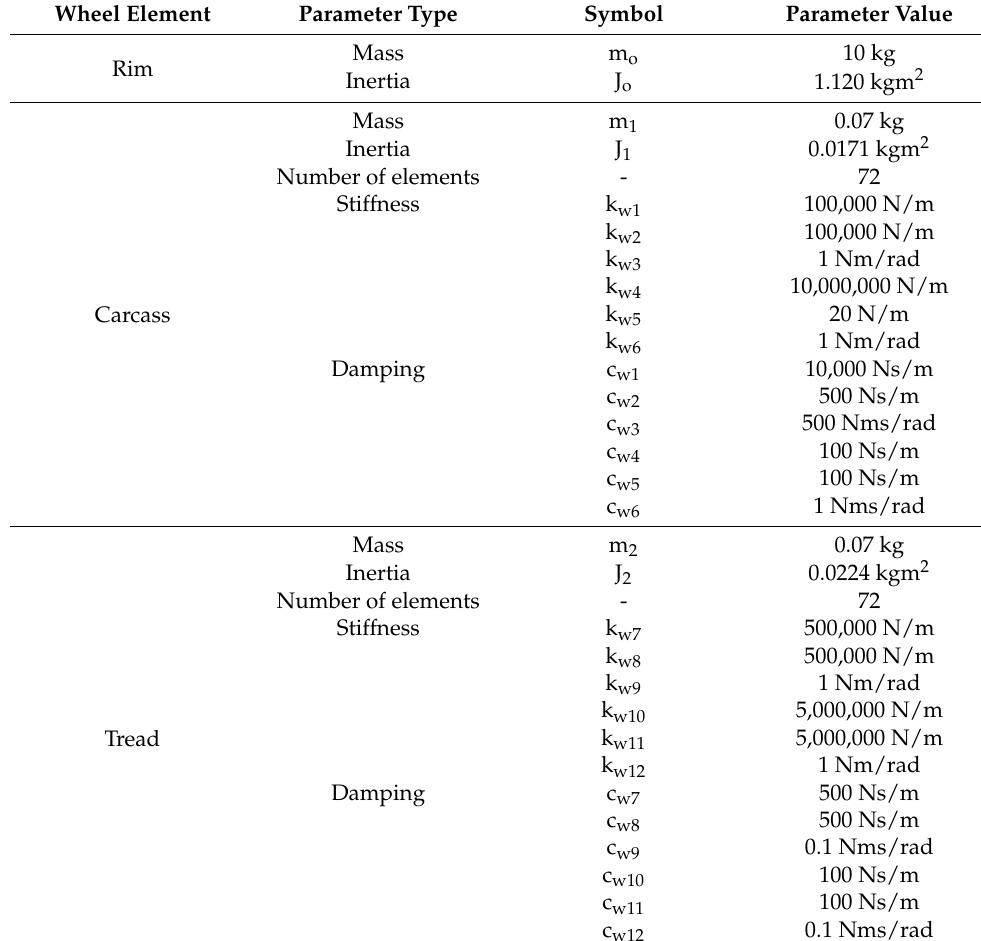
Table 2. Values of main wheel model parameters